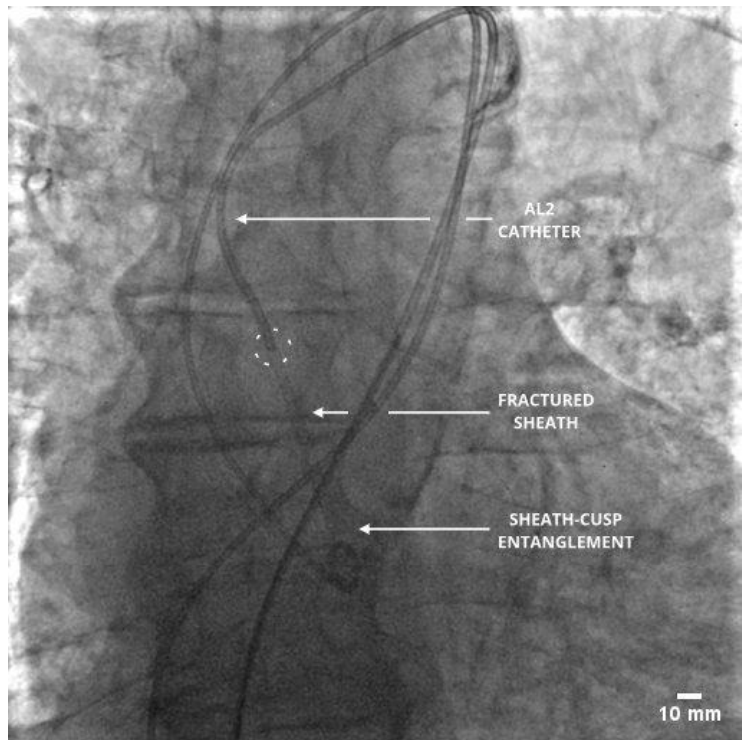
Figure 2. Intra-aortic entrapment of the fractured sheath with the AL2 catheter after the Confida wire removal.